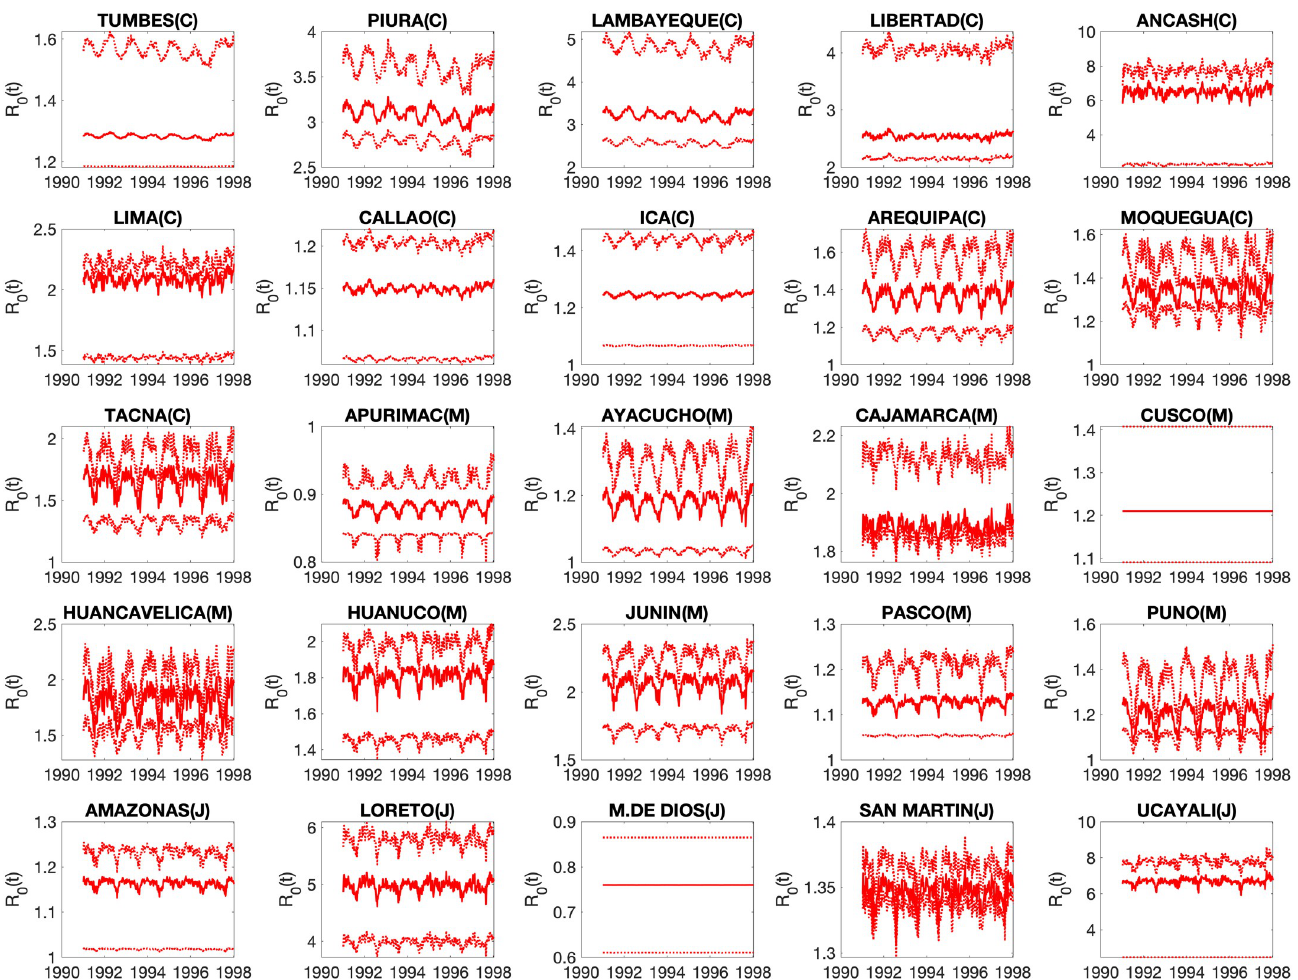
Fig 6. Time-dependent R 0 s across 25 department throughout the epidemic (1991-1997). The mean is the red solid line and the dashed red lines correspond to the 95% confidence